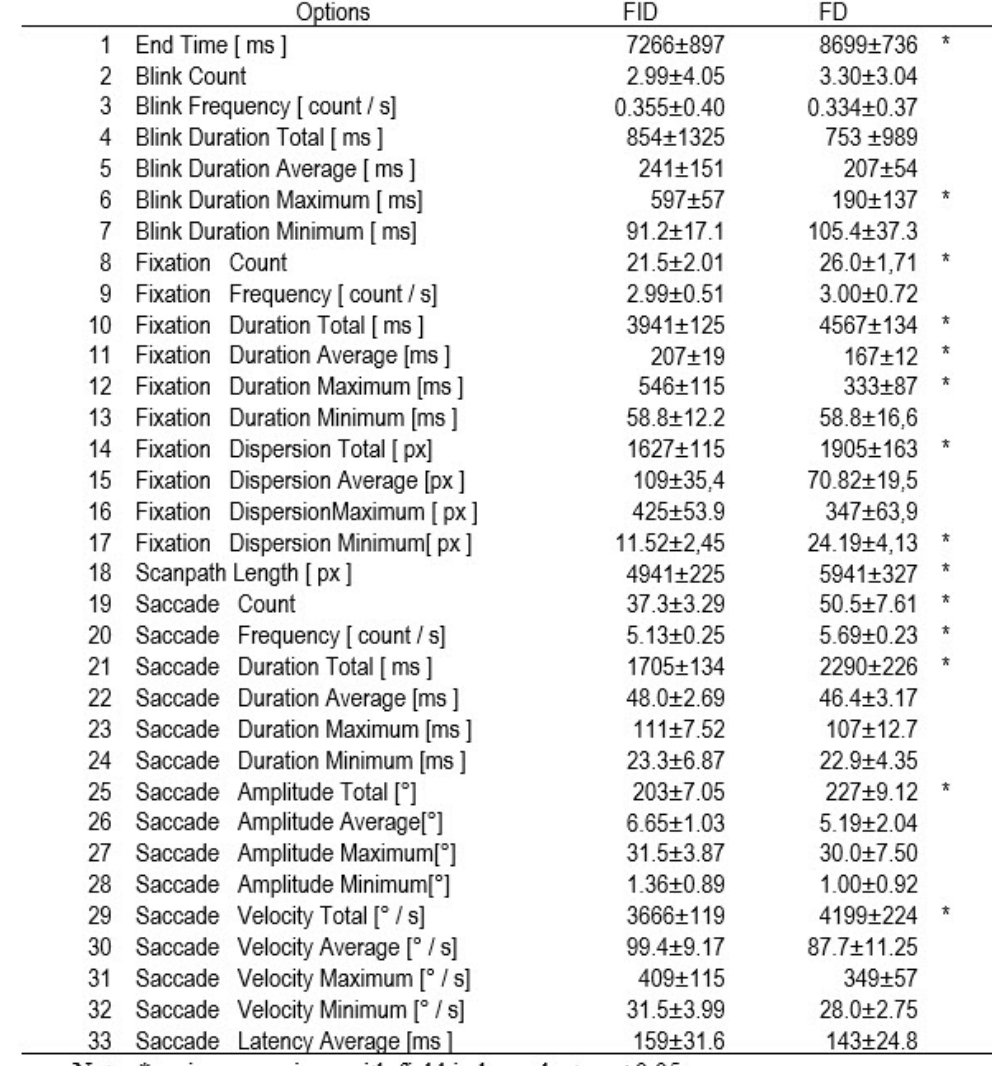
OMA indicators for students with different cognitive styles in solving financial tasks with a probability of winning